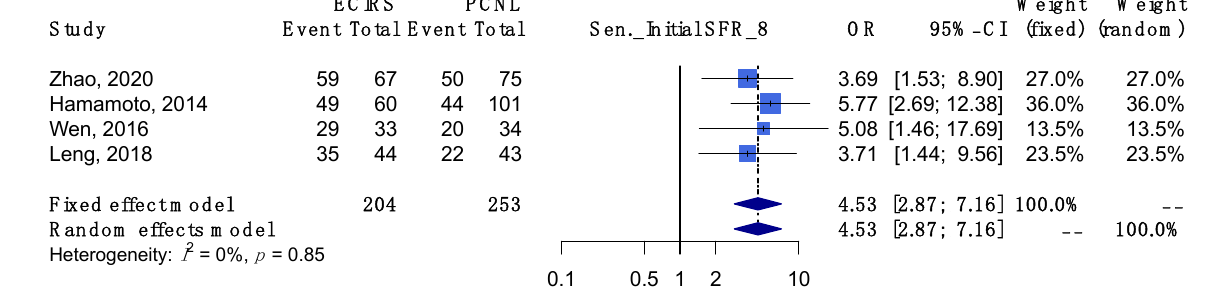
Figure A28. Sensitivity analysis of outcome regarding initial stone free rate. ([17–19,22]).